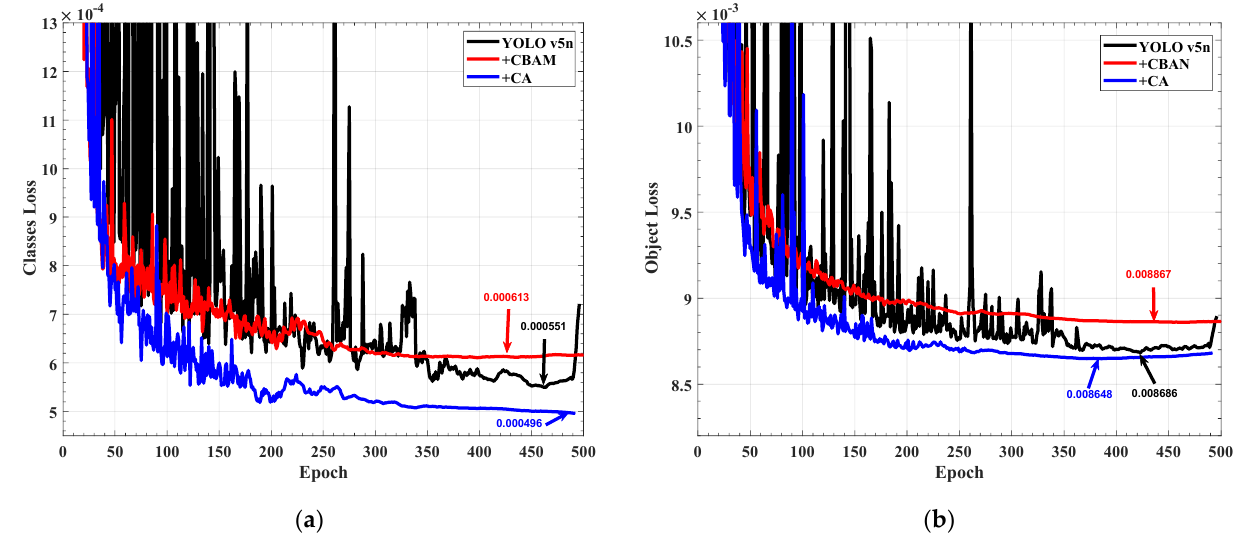
Figure 9. Verification set loss: ( a ) Verification set classification loss; ( b ) Verification set object loss. The mean of average precision (mAP), which is a crucial measurement of the classi- fication accuracy of the model, refers to the average prediction accuracy of each type of target and then the average value of the entire dataset. The recall is a crucial indicator to determine whether the target object has been examined. As shown in Figure 10a, the maximum mAP of the network with the CA module is 96.1%, the maximum mAP of the network with CBAM is 93.9%, and the maximum mAP of the original YOLO V5n model is 94.6%. It can be seen that the CA module improves the classification accuracy by 1.5%, while the CBAM reduces the classification accuracy by 0.7%. The reason why the CBAM module causes network degradation is that the long-distance optical signal object and the mirror target in the training image have high consistency, the target scale is small, and the global features cannot effectively separate the noise and the target. As shown in Figure 10b, the recall rate of the target by the CA module is also improved by 0.8%. In the detection of distant targets, the network with CA has a good effect on recognition and classification. Therefore, in the subsequent experiments to verify the model detection effect, the YOLO V5_CA and YOLO V5n models are used for comparison.